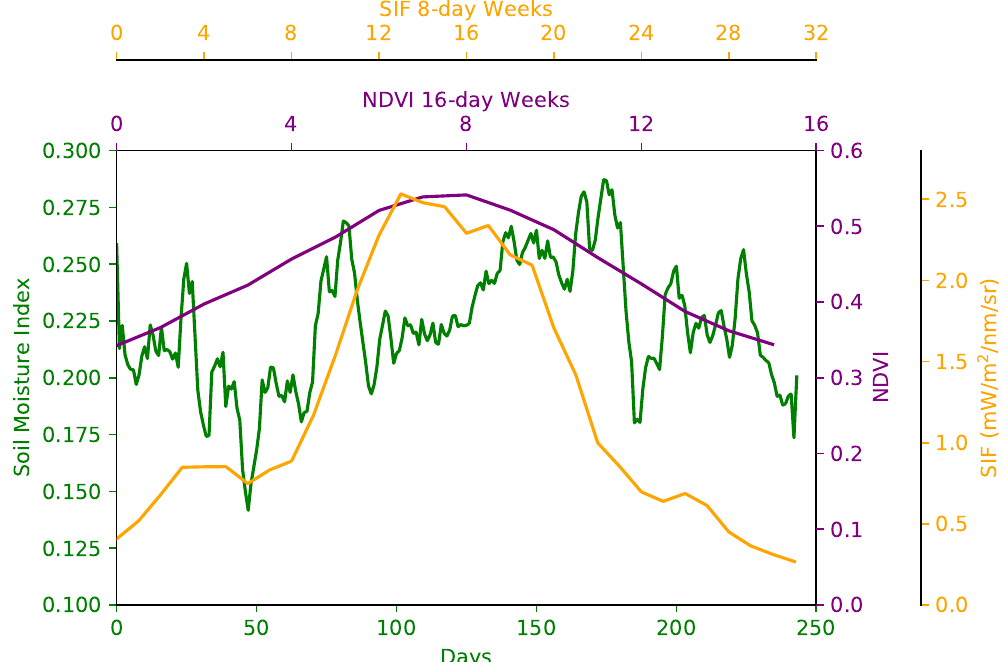
Figure 4. Lead–lag relationship between SIF and plant water need based on soil moisture index calculated from ESA soil moisture data. Soil moisture index is calculated as 1 − SM − SM min is soil moisture value at any given day of the growing season, SM max and SM min are the highest and lowest soil moisture values during the growing season, respectively. The soil moisture index and SIF values are averaged over the study period of 2007–2012. Day 0 corresponds to April 1st, which is considered the beginning of the growing season. SIF, soil moisture and NDVI values are estimated from grids of size 0.5 × 0.5°, 0.25 × 0.25° and 1 × 1 km, respectively, surrounding US-Ne3 FLUXNET station (41.1797 °N, –96.4396 °E). US-Ne3 station has rotated crop assignments: soybean at even years and corn at odd years